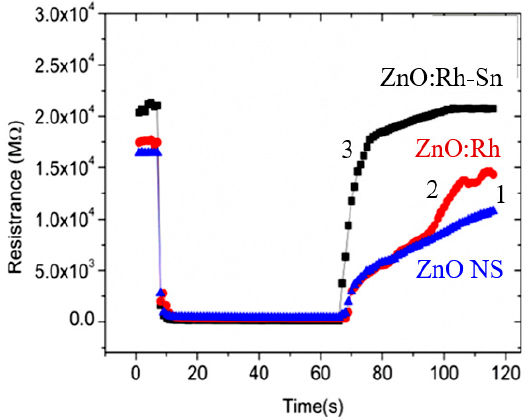
Figure 38. The response and recovery curves of different sensors to 100 ppm ethanol at an optimum working temperature (300 °C): 1—ZnO nanosheets; 2—ZnO:Rh; 3—ZnO:Rh-Sn. Reproduced from Sun et al. [335]. Published by Nature Research as open access.